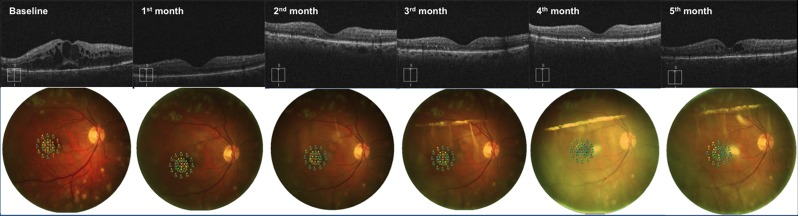
Follow-up of a patient affected by diabetic macular edema undergoing Ozurdex implant.Optical coherence tomography scans and MP1 microperimetry outputs, from a 62-year-old patient affected by diabetic macular edema in his right eye, acquired at baseline visit, 1 month, 2 months, 3 months, 4 months and 5 months after the first Ozurdex injection. The patient underwent a second Ozurdex implant at 5th month because of edema reappearance.